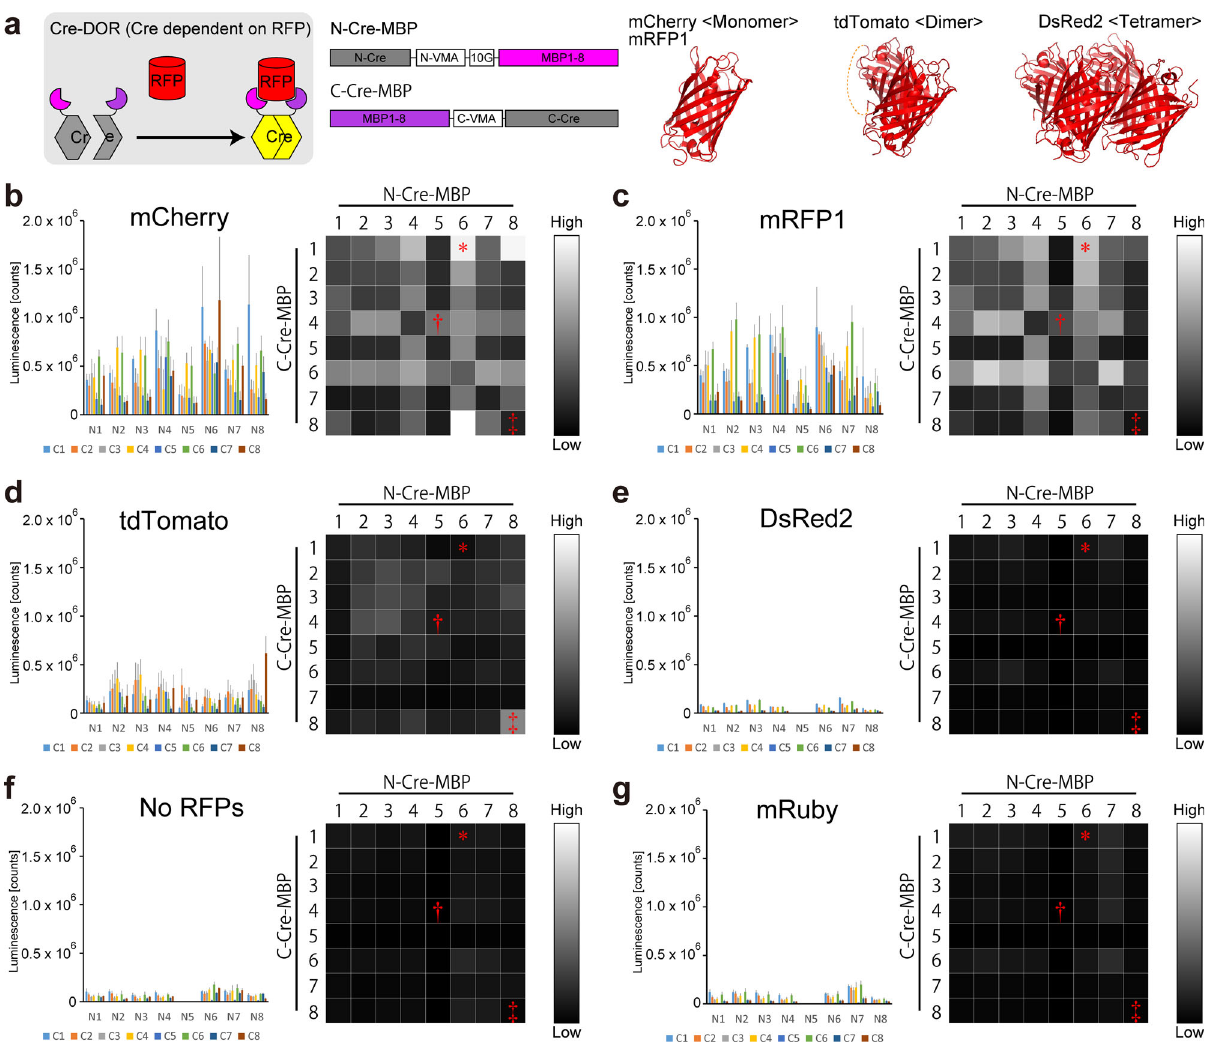
Fig. 1 Luciferase assay screening of ef fi cient MBP pairs for Cre-DOR. a Schematic presentation of the construct of Cre-DOR. N- or C-terminal split Cre recombinase is fused with mCherry-binding nanobody or DARPin. Binding of RFPs induces reunion of N-Cre and C-Cre into functional Cre recombinase. While mCherry and mRFP1 are monomeric, tdTomato is dimeric. b – g Luciferase assay screening of functional pairs of MBPs for mCherry ( b ), mRFP1 ( c ), tdTomato ( d ), DsRed2 ( e ), No RFPs ( f ) and mRuby ( g ). Every intensity value was normalized by the maximum value and the normalized value is indicated as brightness of 256 levels of gray. VMA: vacuolar membrane ATPase subunit, N-VMA: N-terminal portion of VMA, C-VMA: C-terminal portion of VMA, 10 G: 10 glycine linker. Cre-DOR N6C1 , Cre-DOR N5C4 , and Cre-DOR N8C8 are marked using *, † , and ‡ ,